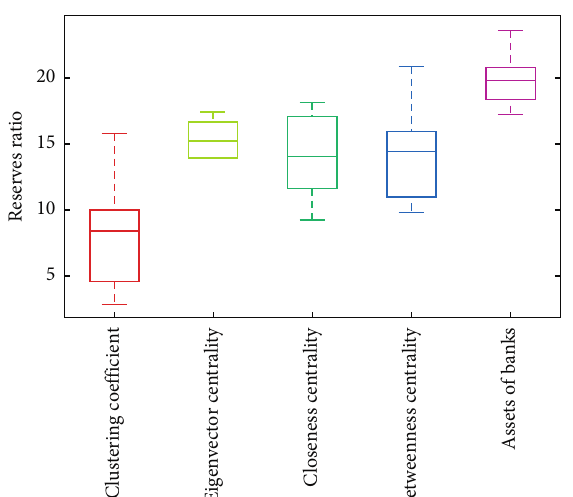
Figure 8: The relationship between the average percentage of the reserves ratio and the different initial attack strategies based on 1000 Monte Carlo simulations to organize networks N ( 768 , 100 , 2 , 5 ) when the cascading default spreads no further.